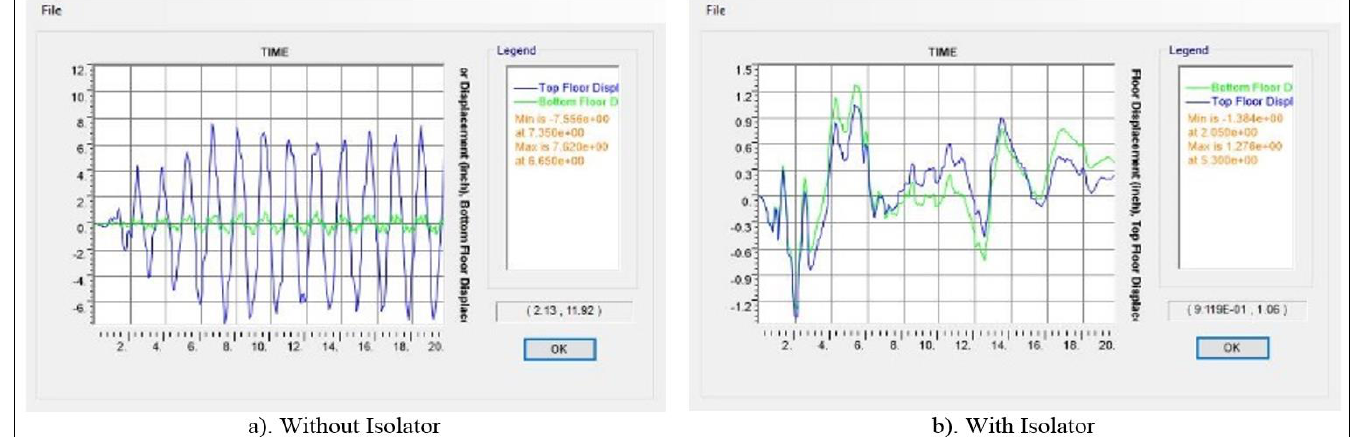
Figure 11: Top and bottom displacement vs time curve (20 sec).